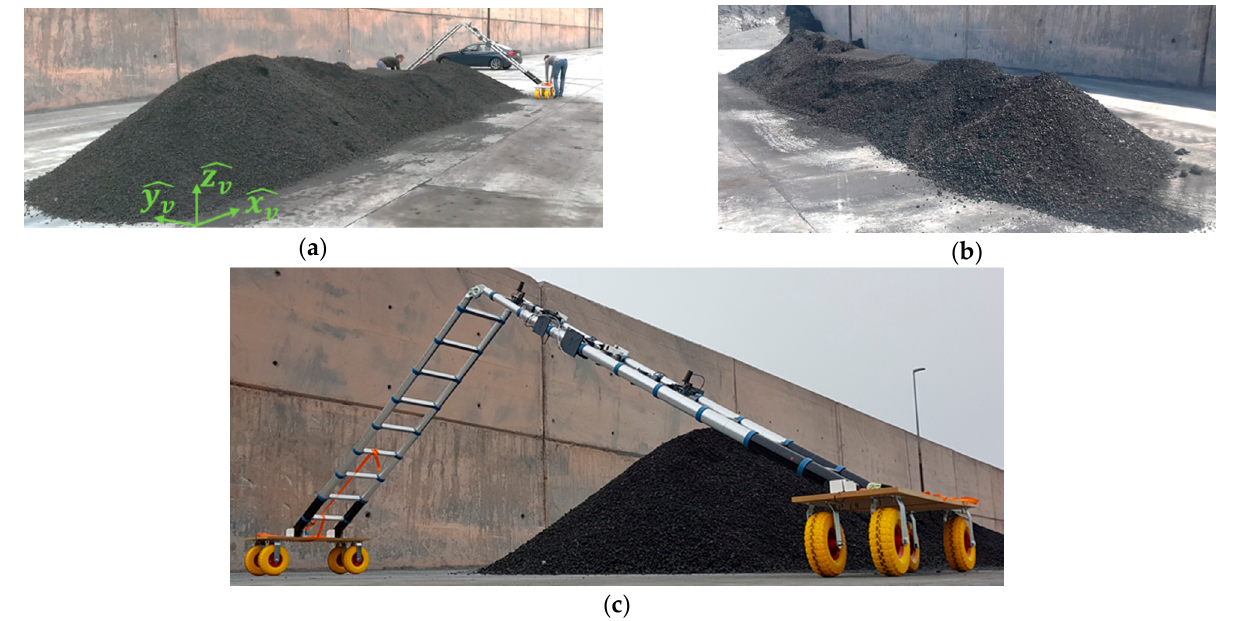
Figure 7. ( a , b ) Scaled stockpile from two different perspectives; ( c ) the ladder with the sensors prior to conducting the stockpile scanning.